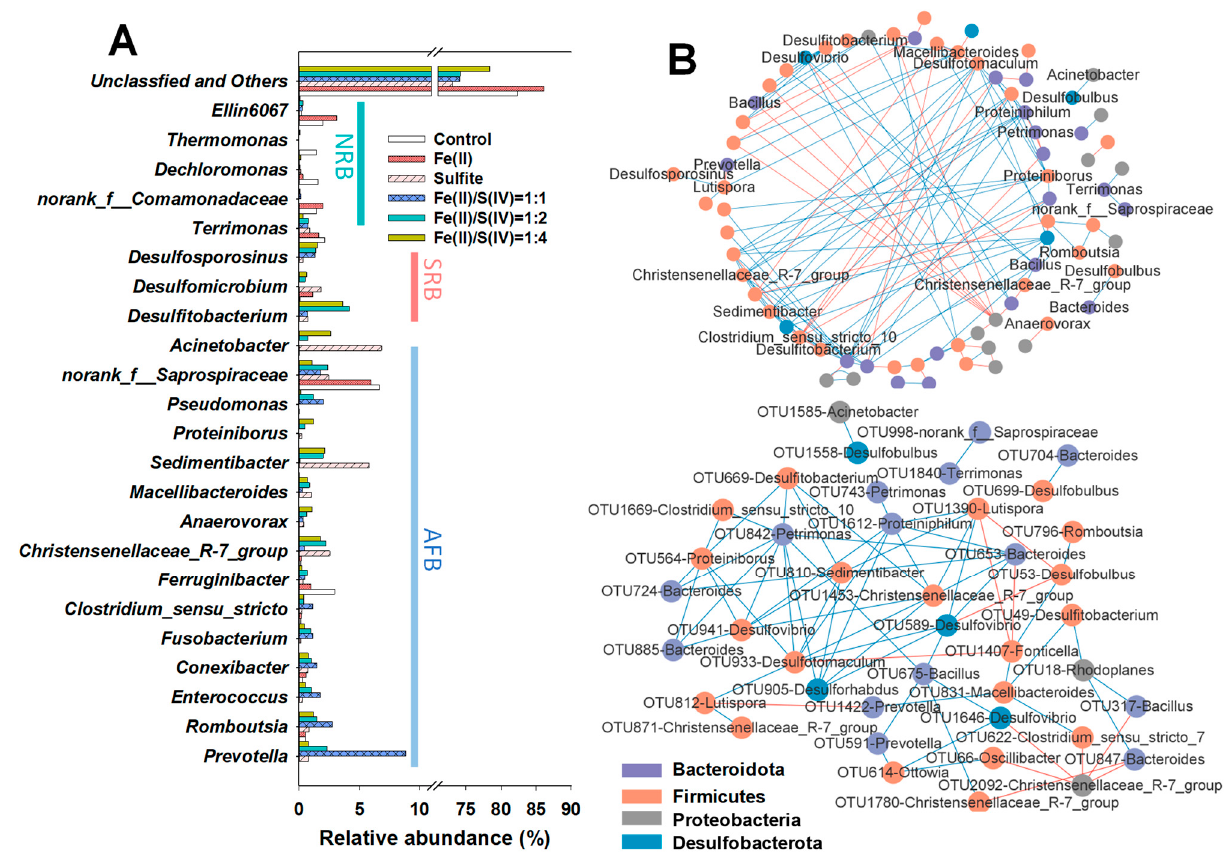
Figure 4. Relative abundance of functional bacteria at genus level ( A ). Molecular ecological network visualization of OTUs from functional microbial consortia ( B ).